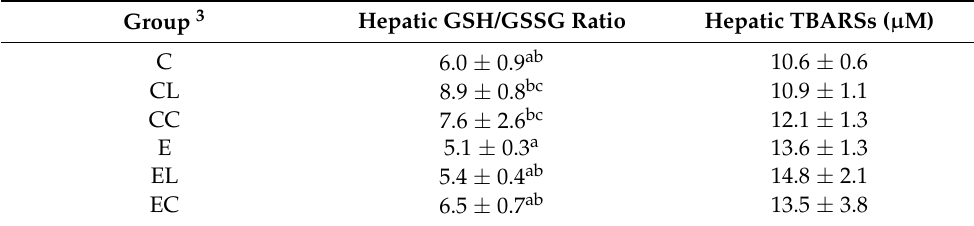
Table 8. Effects of different dietary fat sources on the antioxidant status in rats 1,2 .